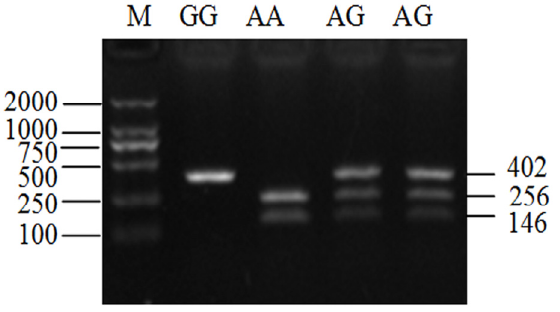
Figure 2. PCR-RFLP analysis of ldhb G896A mutation. M: DL2000 DNA marker (bp). PCR products were digested by Taq I and separated by agarose electrophoresis. Genotypes are indicated on the top of each lane.